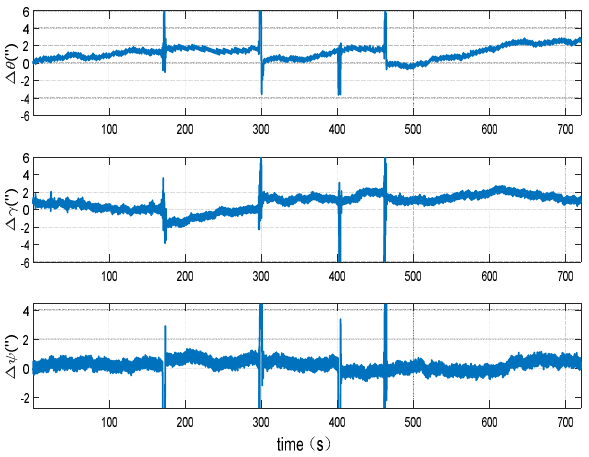
Figure 14. Attitude difference of two INSs after compensated misalignment angles.